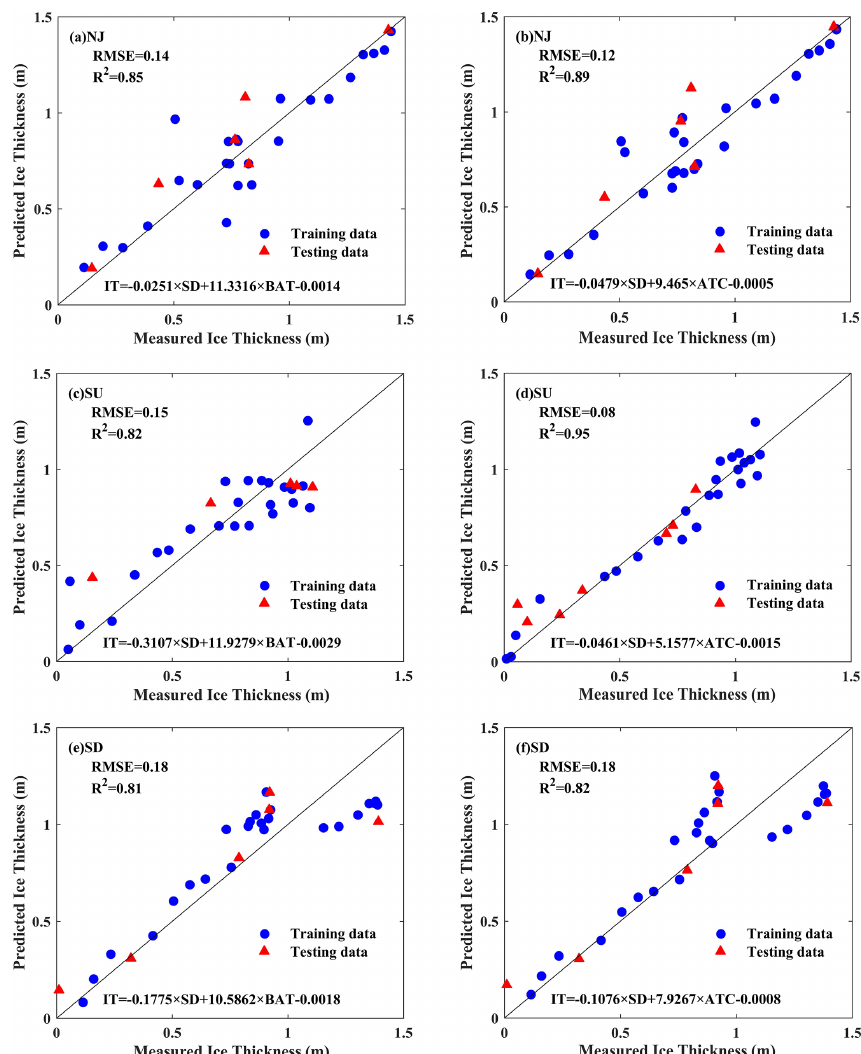
Figure 9. Scatter plots between measured and predicted ice thicknesses using Bayesian linear regression in three subbasins (NJ: Nenjiang Basin; SU: upstream Songhua River Basin; and SD: downstream Songhua River Basin) in northeast China. The model treated ice thickness as the independent variable and snow depth and air temperature as dependent variables. Two types of air temperature were used: BAT represents air temperature on bank, and ATC represents the cumulative air temperature of